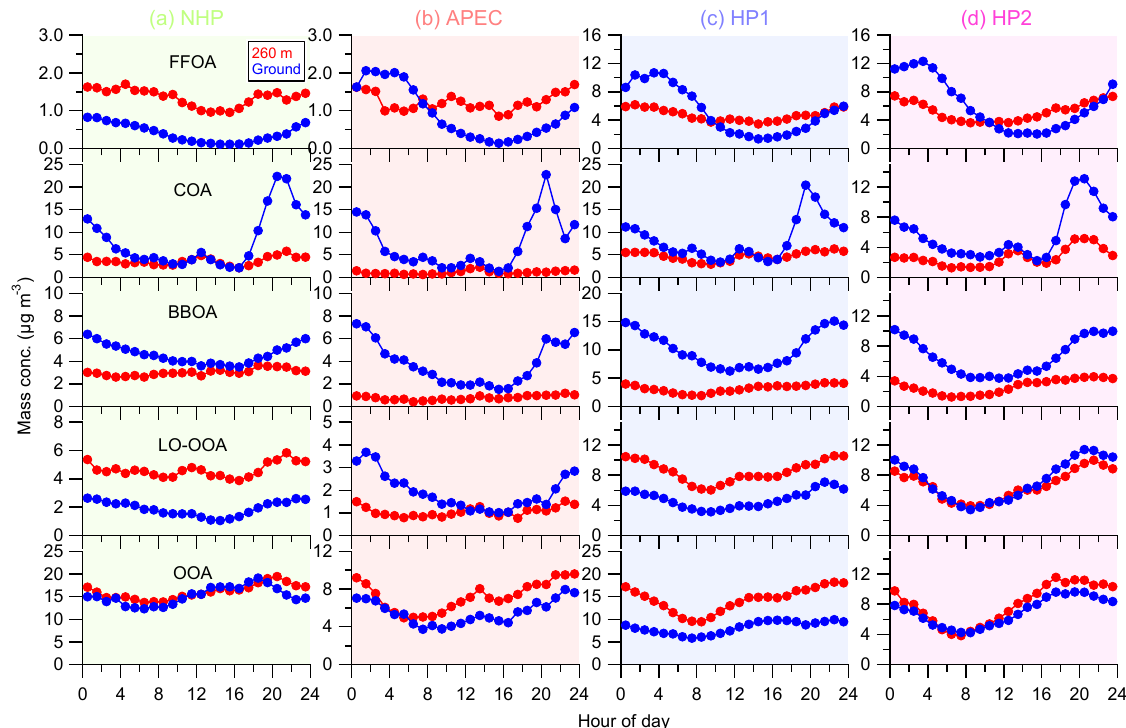
Figure 7. Diurnal cycles of OA factors during the four different periods (a–d) , i.e., NHP, APEC, HP1, and HP2. The OA factors resolved at the ground site are also shown for comparison.